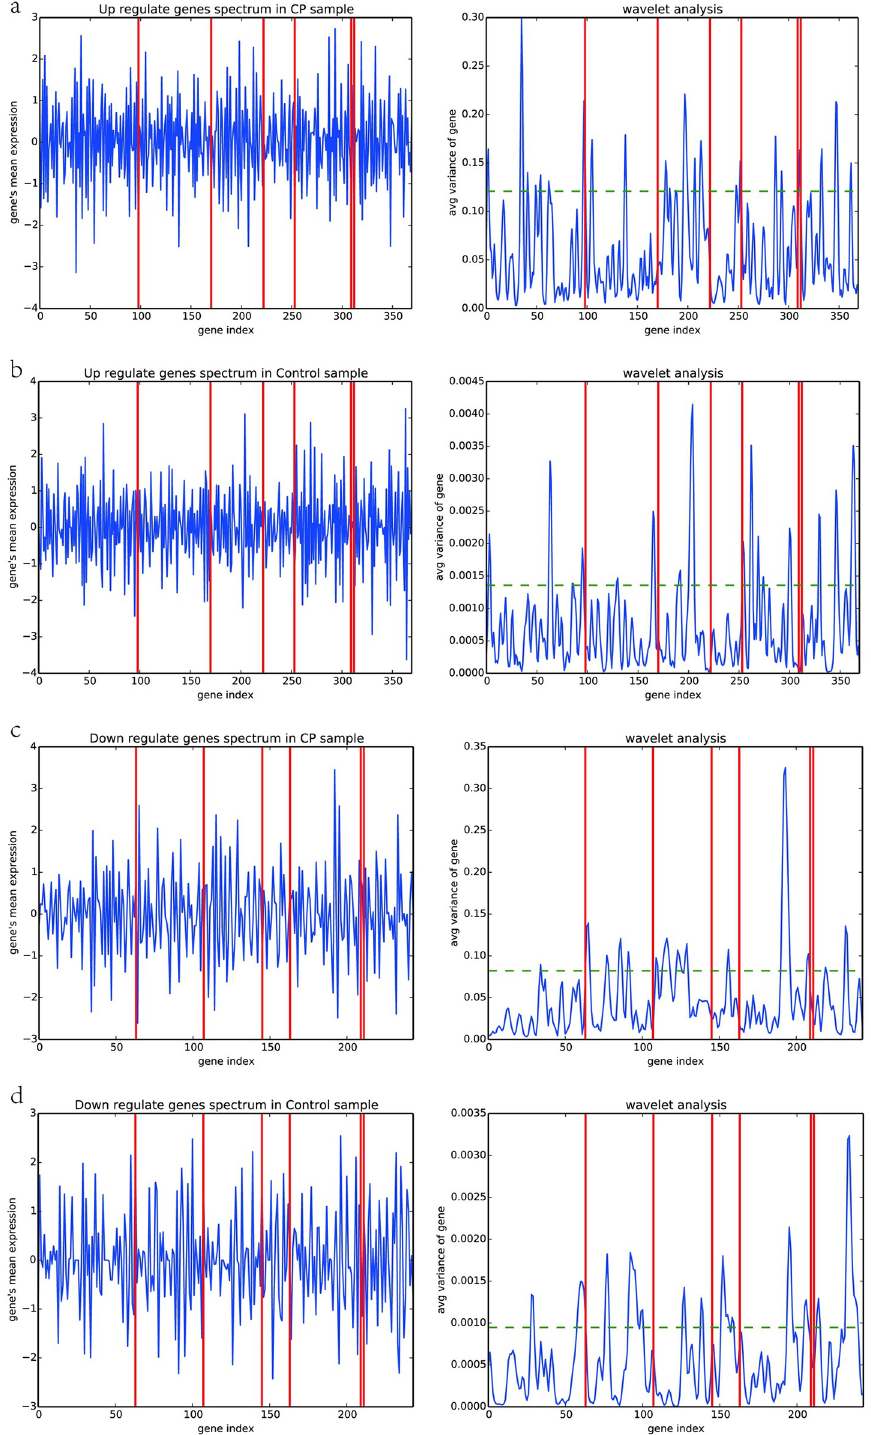
Fig 9. (a) up genes in the case group; (b) up genes in the control group; (c) down the gene in case group; (d) down the gene in the control group.